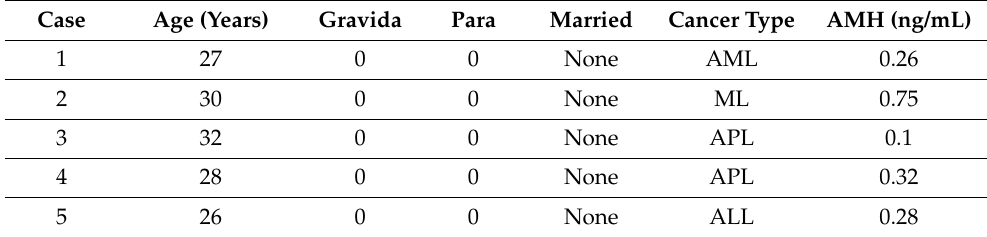
Table 1. Patient’s characteristics.